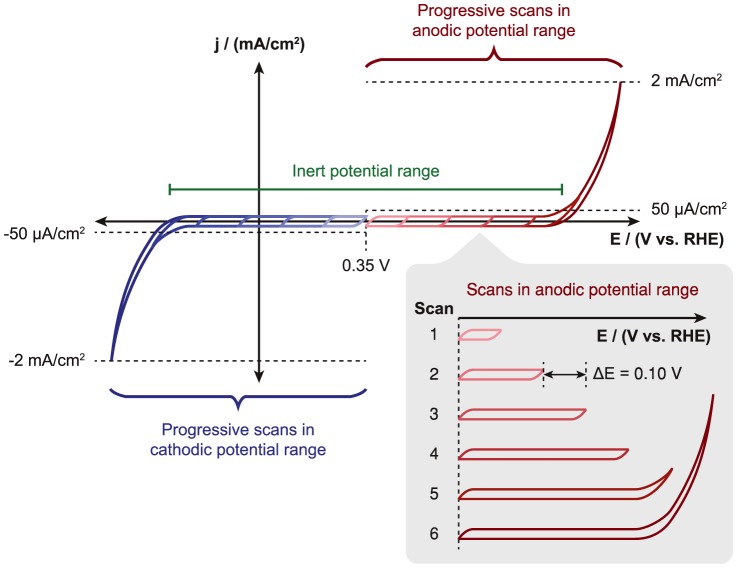
Testing methodology.